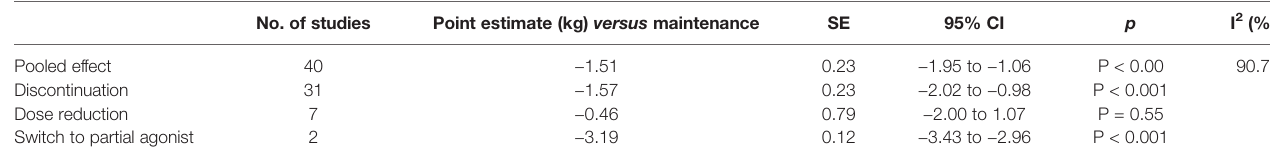
TABLE 2 | Pooled results of primary outcomes, pooled and grouped by type of intervention) measured in kilograms (kg) with standard error (SE). No. of studies Point estimate (kg) versus maintenance SE 95% CI p I 2